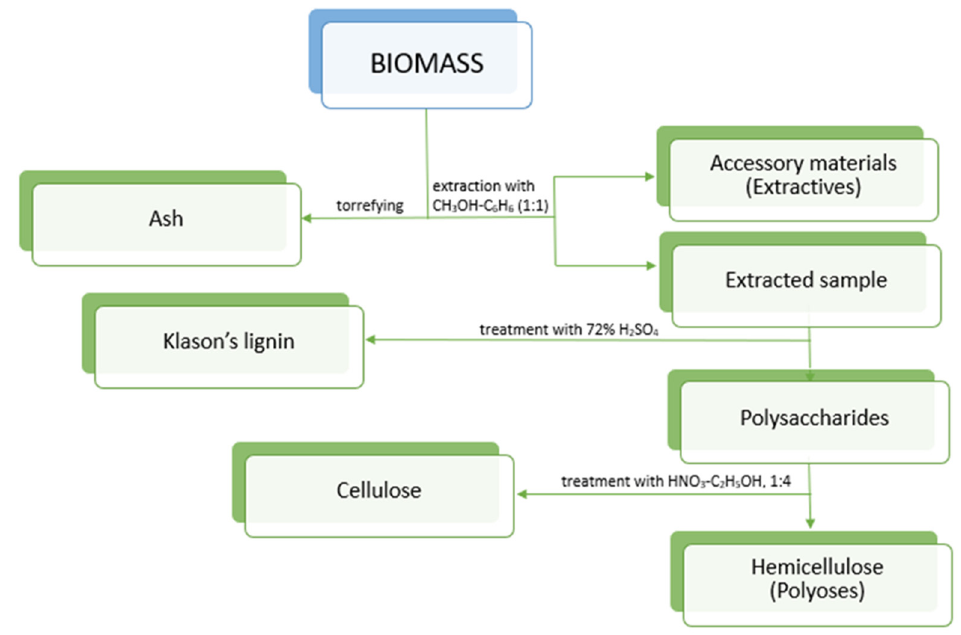
Figure 1. Schematic view of sample chemical analysis [34].